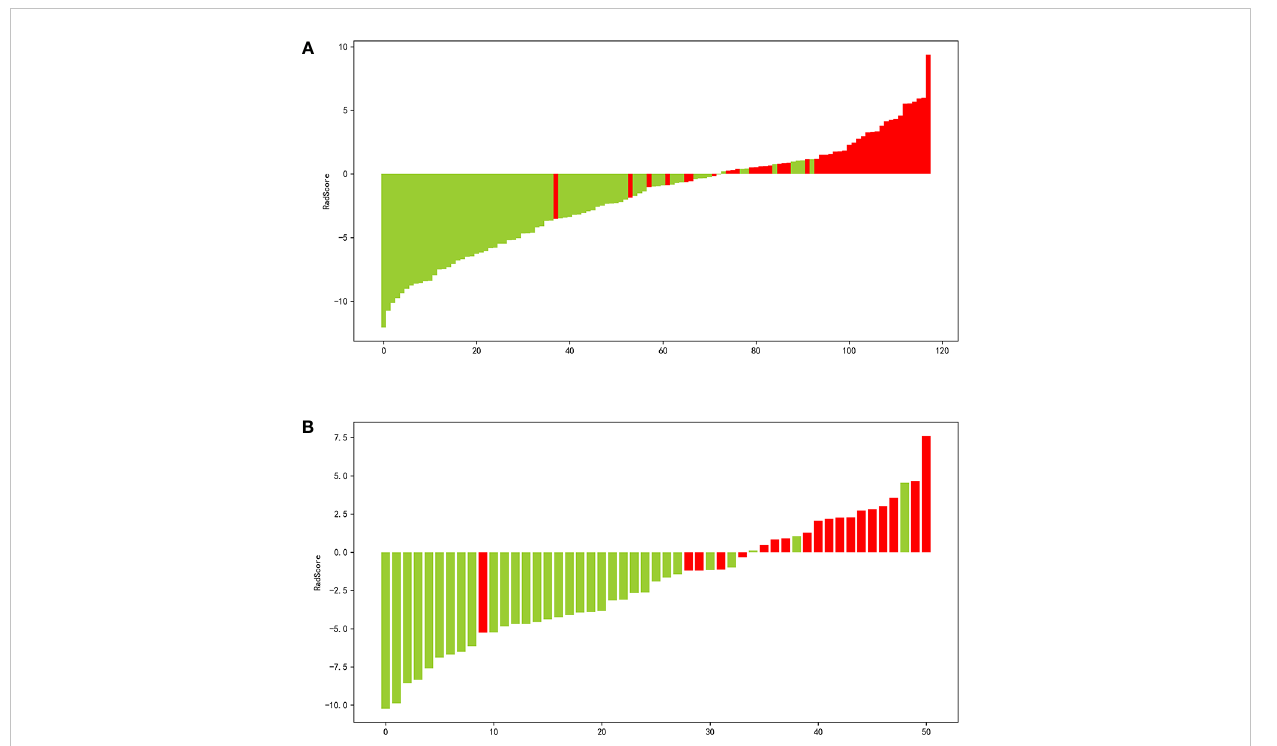
FIGURE 4 Waterfall plot of the distribution of radiomics score and pathological grade of individual patients in the in the training (A) and validation (B)